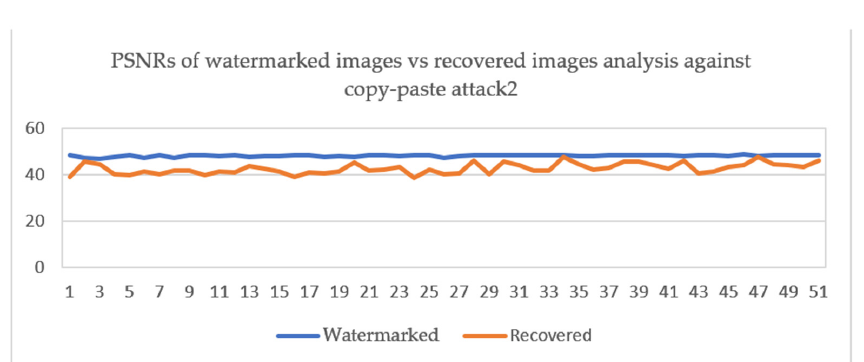
Figure 15. PSNRs of watermarked images vs. recovered image analysis against cutting attack 1.